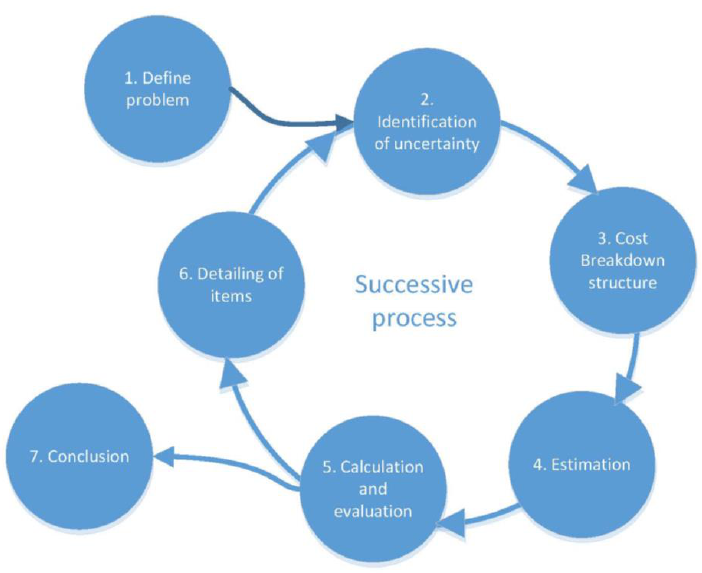
Figure 1. The overall analysis model, from the input of the process to the analysis results.